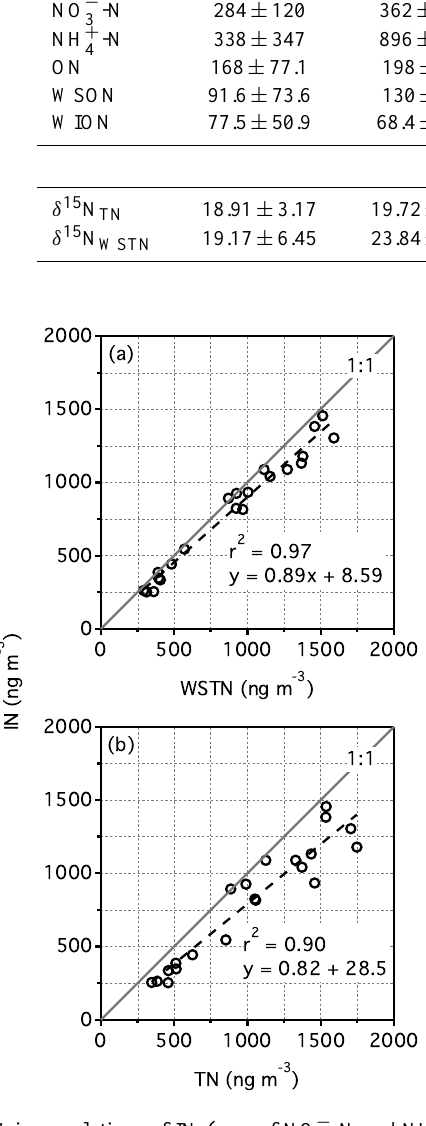
-N and NH + -N) to 3 4